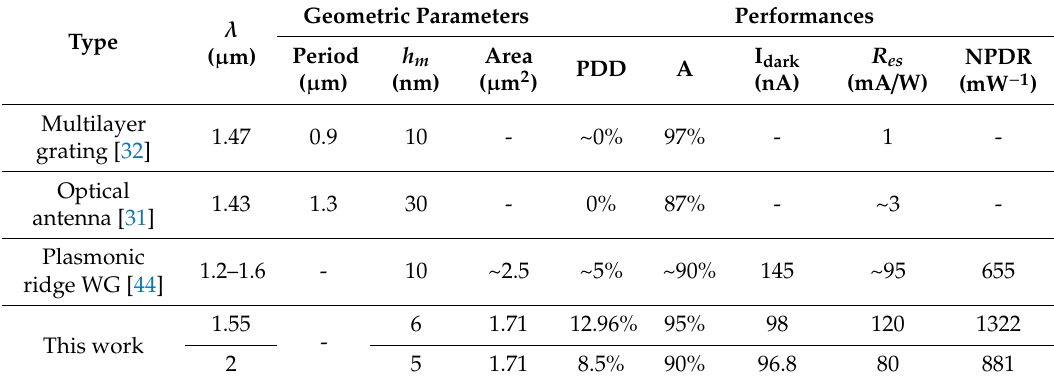
Table 3. Performances comparisons with reported works on polarization-insensitive Schottky PDs. Geometric